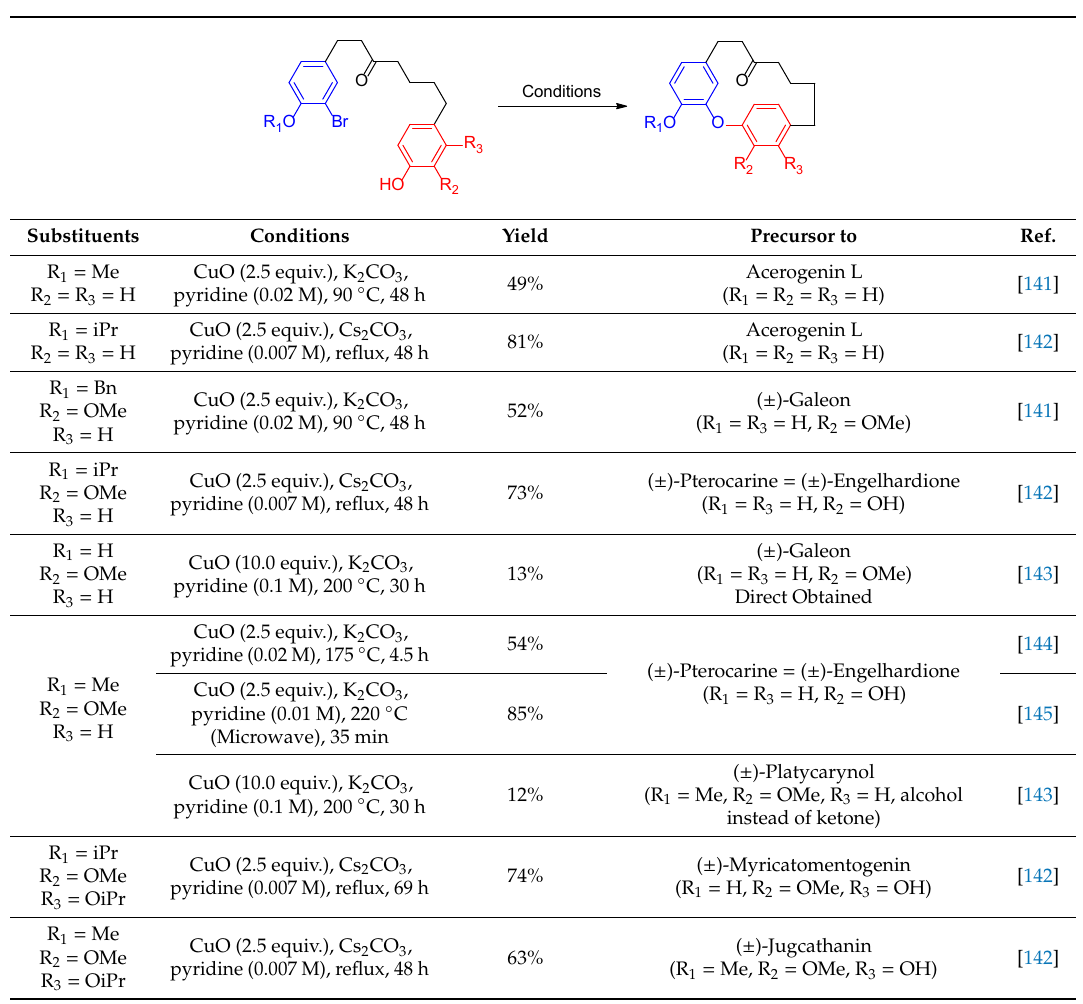
Table 11. The macrocyclic ether compound heptanoids that occur naturally prepared through an intramolecular Ullmann coupling reaction based on the condition that proposed by Tomita, Fujitani, and Aoyagi.